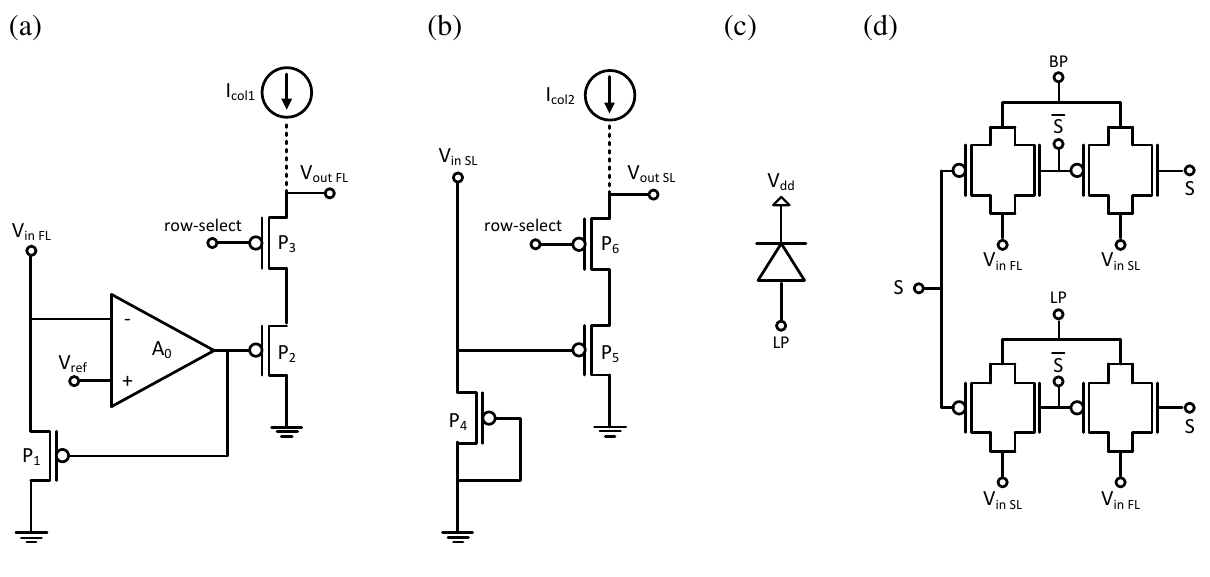
Principle schematics of the designed CMOS